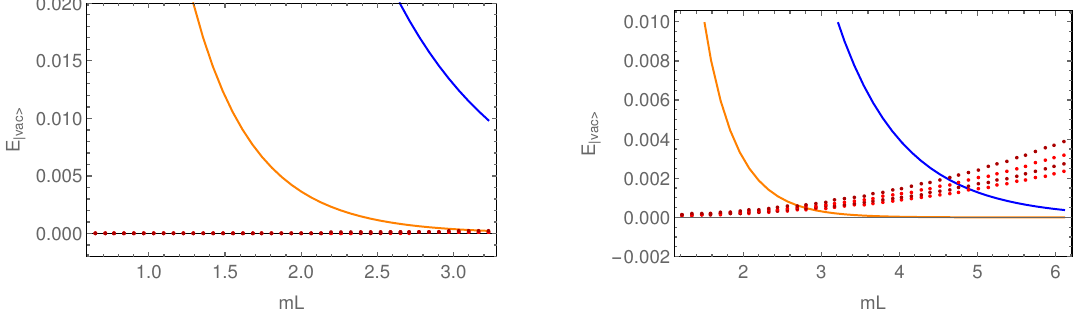
Figure 4 . Volume dependence of the ground state energy in sinh-Gordon model: comparison of TCSA data with BY, L(cid:127)uscher and TBA predictions for b = 1 (left) and b = 2 (right). On these plots, the TBA predictions are subtracted from each data set. TCSA measurement points are shown with red and brown dots, corresponding to di(cid:11)erent chiral cuto(cid:11)s (from bottom up: 9 ; 8 ; 7 and 6). The di(cid:11)erence between the BY lines and TBA (blue) and between BY+leading L(cid:127)uscher and TBA (orange) are also indicated. For b = 1, TCSA results agree with TBA data to a remarkable precision (the di(cid:11)erence is negligible, as well as the cuto(cid:11) dependence thereof). For b = 2 truncation errors become more